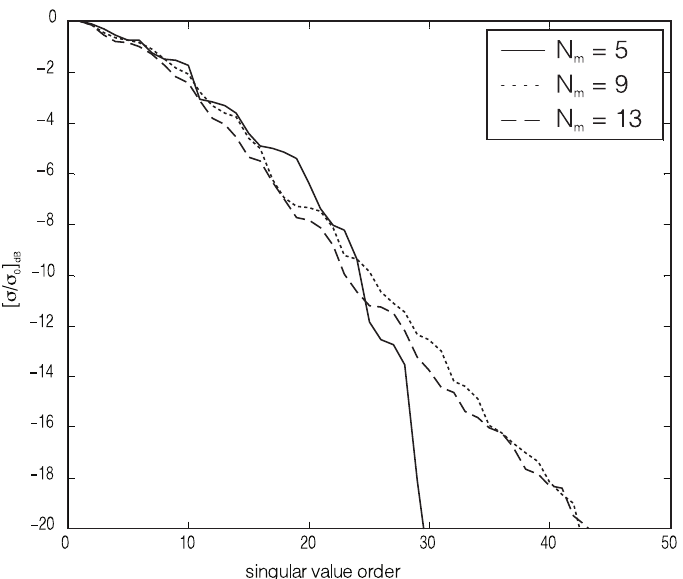
Fig. 2. Behavior of the normalized singular values of L (and receiver) positions. A suitable choice is N